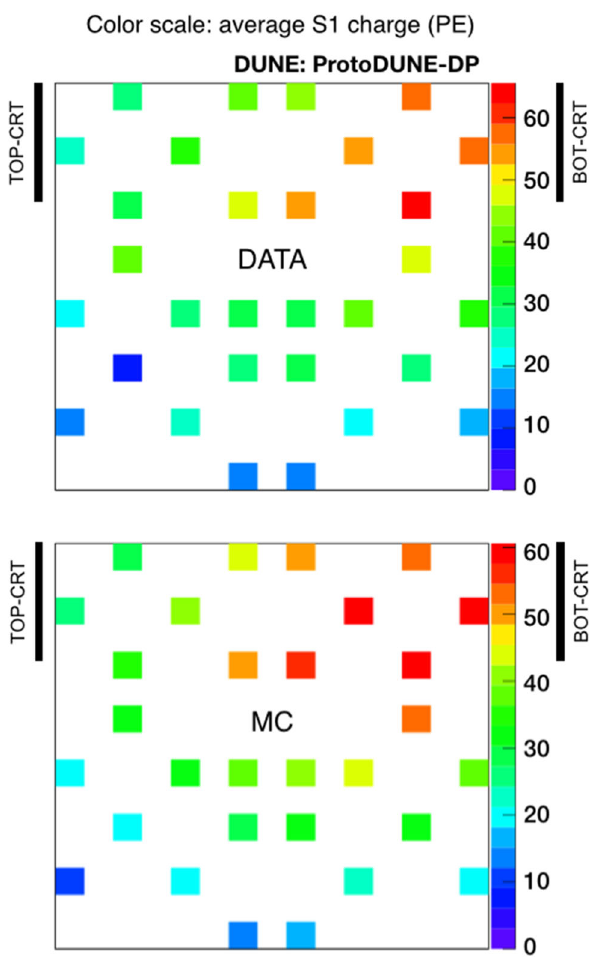
Fig. 16 Average S1 charge per channel (in PE) in CRT-trigger mode: top view of PEN-PMT array for data (top panel) and simulation (bottom panel). Each color square represents one PMT channel at its position in thedetector. Theapproximate positionsoftheCRTframes areindicated with black lines